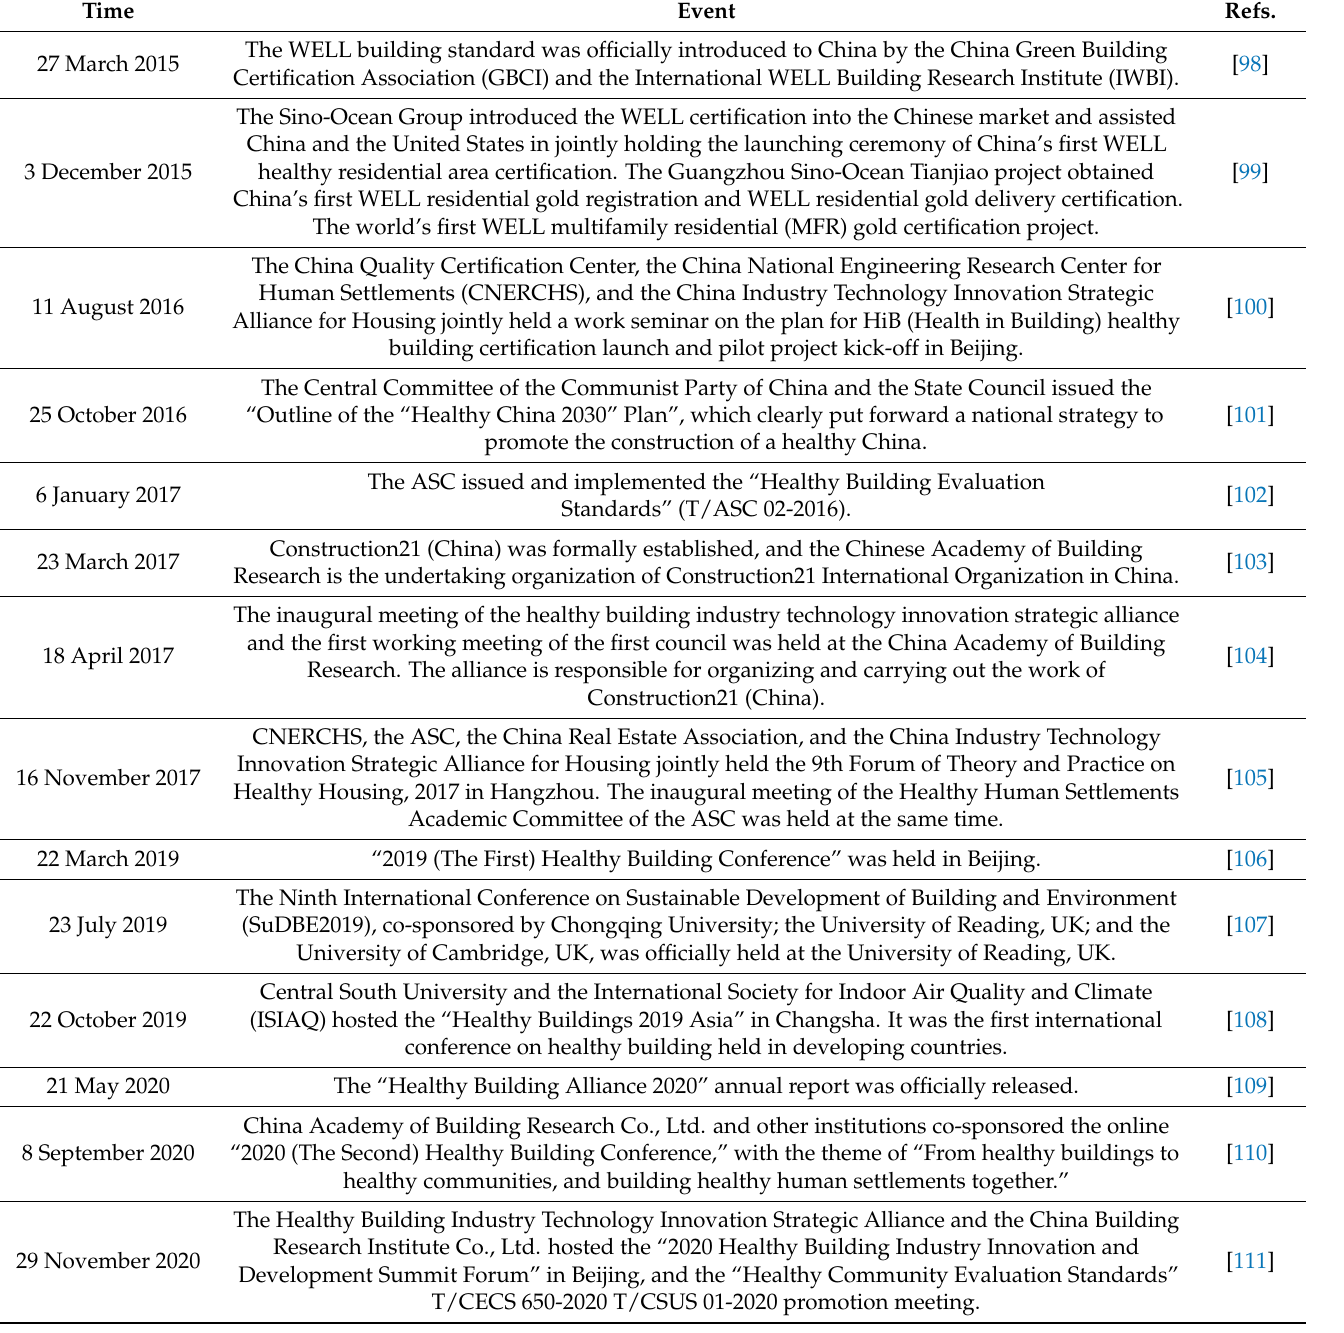
Table 3. Milestones of healthy building development in China. Time Event